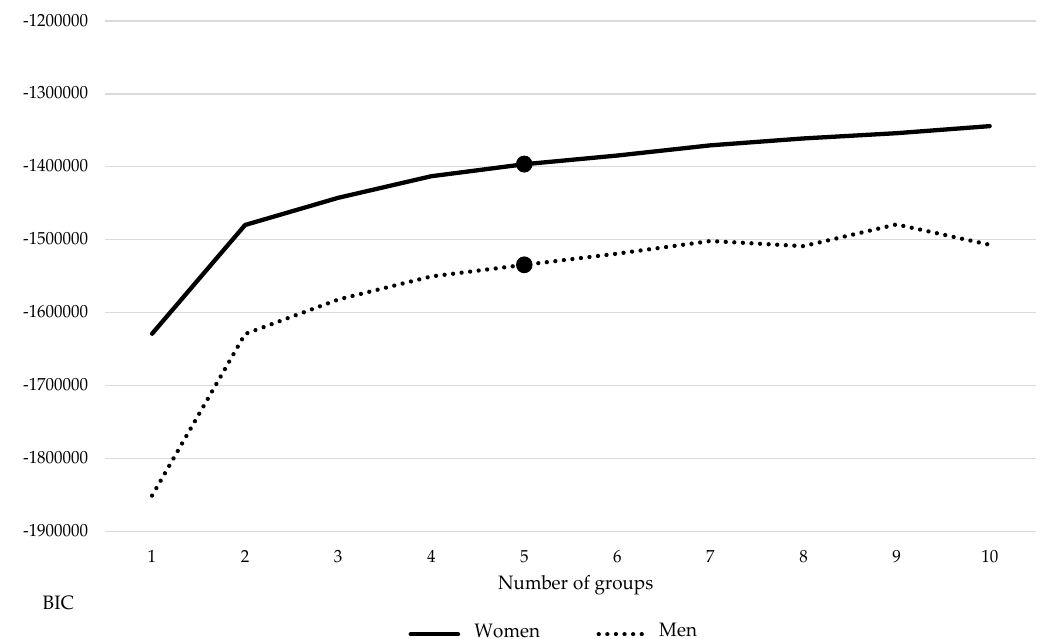
Figure A1. Bayesian information criterion (BIC) values of the trajectory analysis with di ff erent number